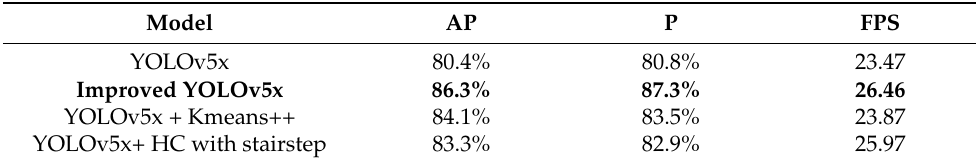
Table 2. Comparison results of ablation experiments.